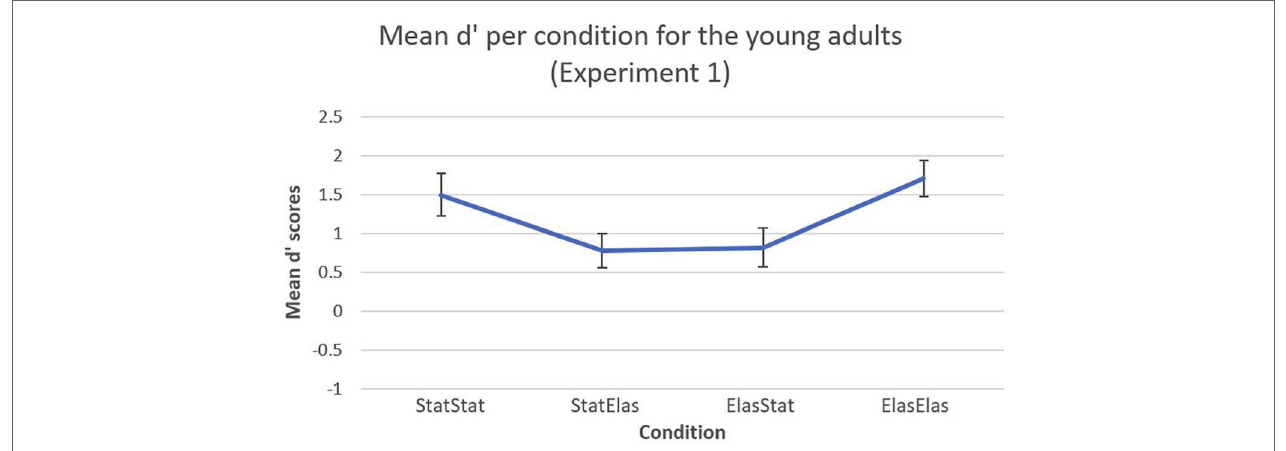
FIGURE 2 | Mean d’ recognition scores (and error bars) per condition. In the static-static and elastic-elastic conditions, participants showed higher sensitivity in detecting target faces compared to the other